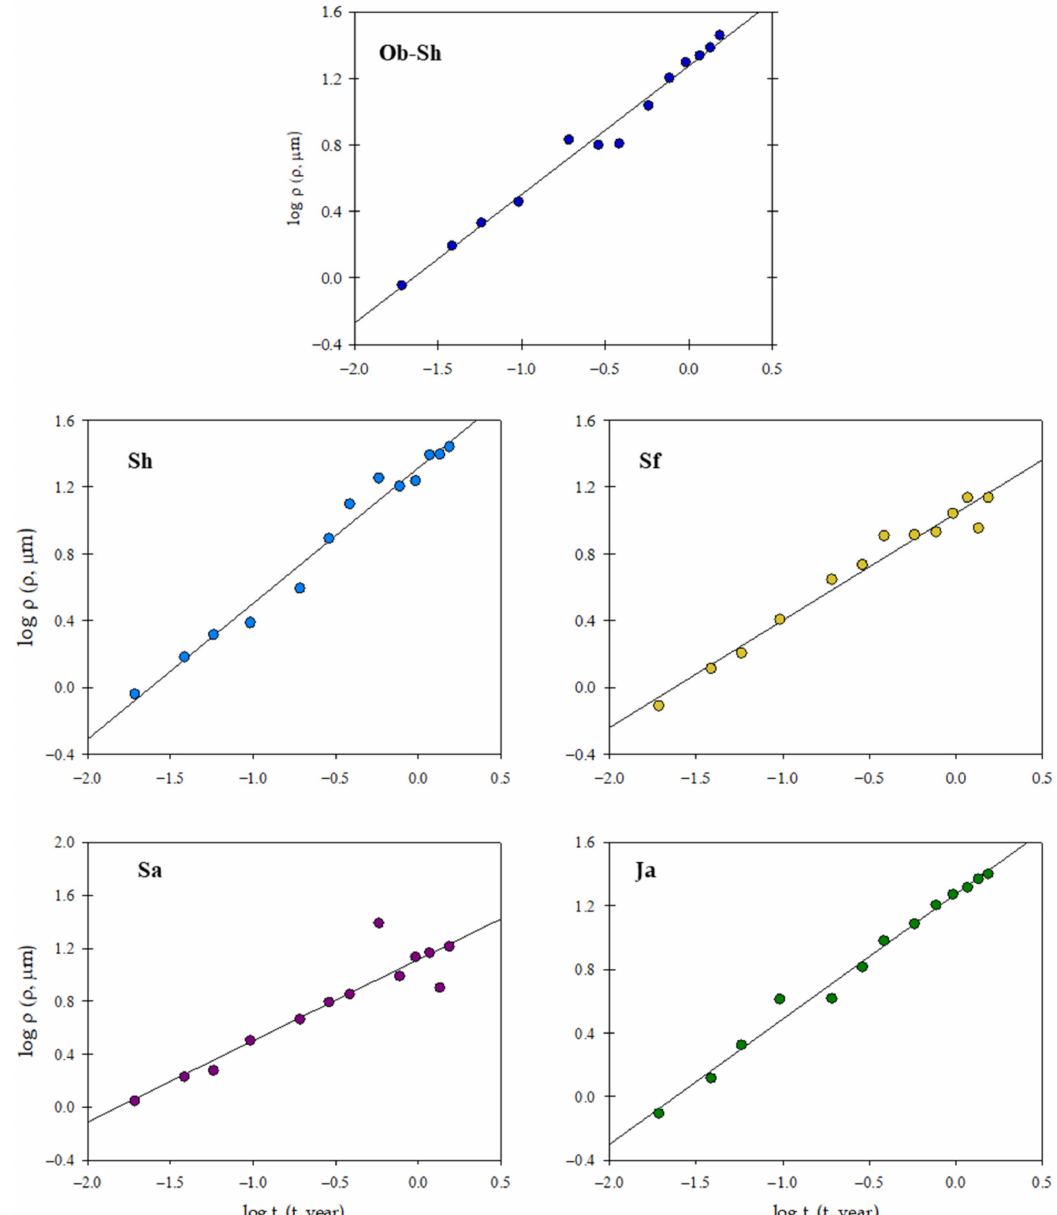
Figure 5. log ρ as a function of log t for the corrosion of CSX36 specimens over 80 weeks of immersion in the studied Jeddah soil solutions at 23 ± 1 ◦